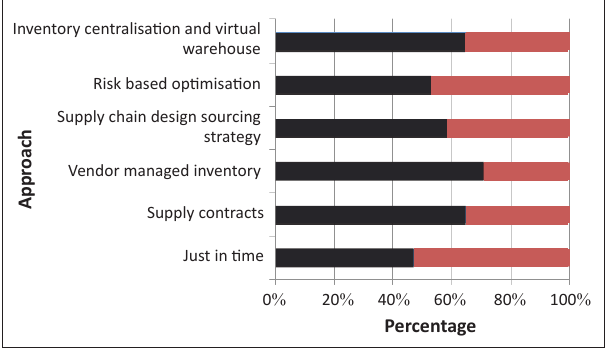
FIGURE 6: Inventory management approaches used by cement